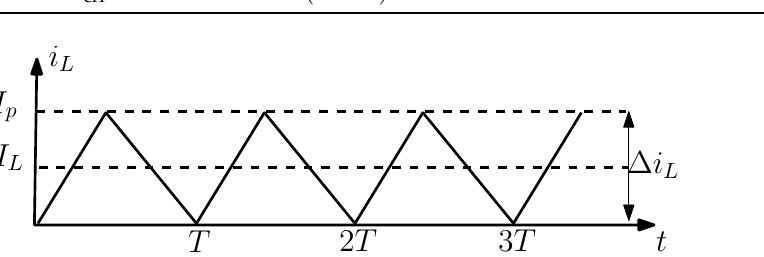
Figure 6. Steady-state inductor current i L at the boundary of CCM–DCM for any elementary